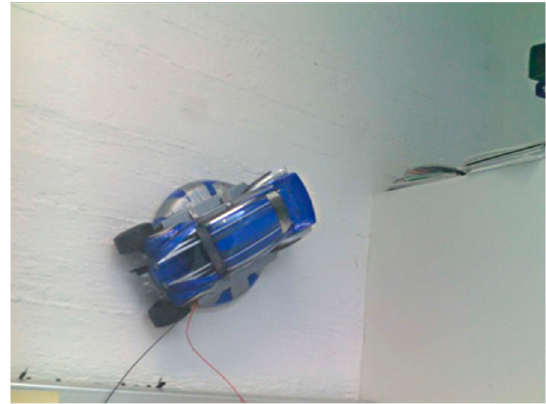
Figure 19. WMR prototype. Figure 19. WMR